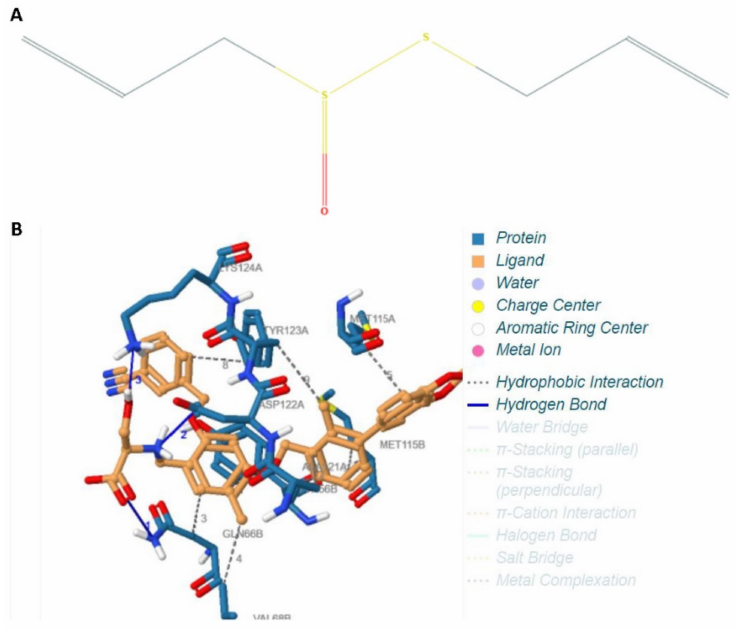
Figure 1. Structure and docking of allicin. ( A ) One-dimensional chemical structure of allicin. ( B ) Docked configuration of allicin and PD-L1 .